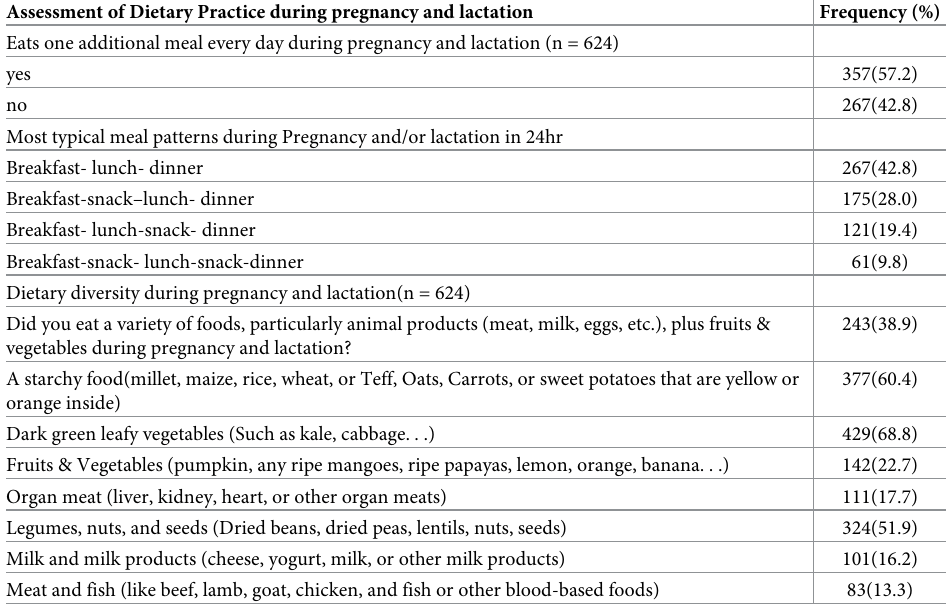
Table 4. Pattern nutrition during pregnancy and lactation among mothers of children aged 6–24 months in Lemo District, Southern Ethiopia, 2021. Assessment of Dietary Practice during pregnancy and lactation Frequency (%) Eats one additional meal every day during pregnancy and lactation (n = 624) yes 357(57.2) no 267(42.8) Most typical meal patterns during Pregnancy and/or lactation in 24hr Breakfast- lunch- dinner 267(42.8) Breakfast-snack–lunch- dinner 175(28.0) Breakfast- lunch-snack- dinner 121(19.4) Breakfast-snack- lunch-snack-dinner 61(9.8) Dietary diversity during pregnancy and lactation(n =